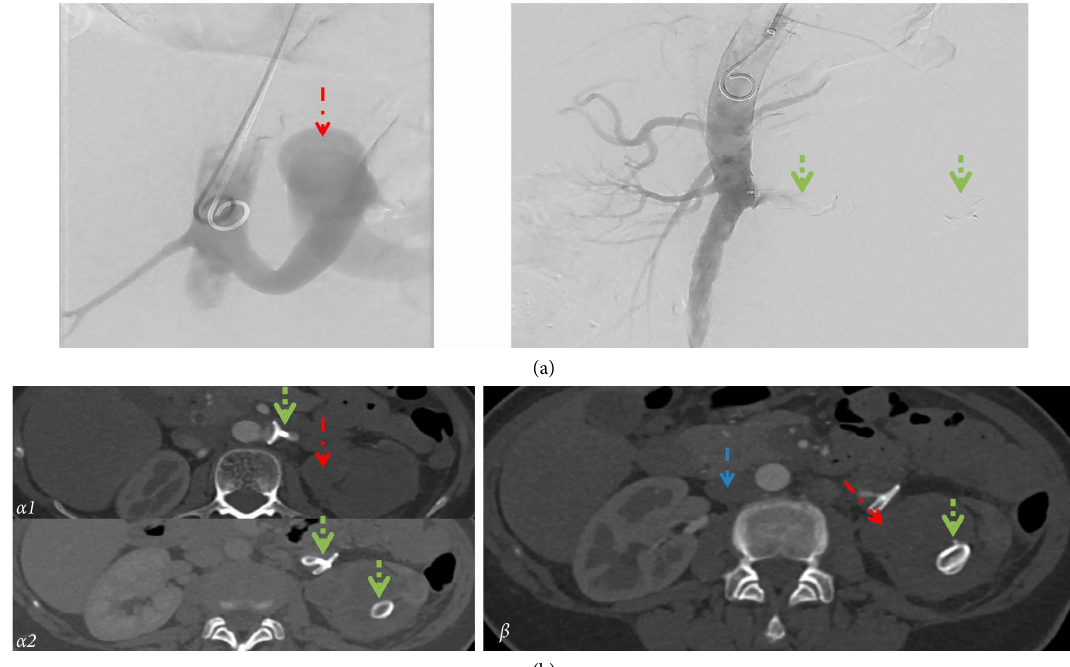
Figure 3: Representative images of an angiography during surgery and a CT scan one-month post-surgery. (a) Angiography before and after Amplatzer Vascular Plug (AVP) II Device placement. No perfusion of the left renal artery (LRA) after AVP II placement. Red arrow (dashed and dotted) = RVA; Green arrow (dotted) = correct positioned central and displaced peripheral AVP II. (b) 𝛼 : arterial phase images. 𝛼 1: no perfusion of the LRA distal of the central AVP II. 𝛼 2: minimal residual cortical perfusion over a side-branch originating from the LRA proximal of the central AVP II. 𝛽 : venous phase image: no contrast in the left vs. right kidney indicating subtotal infarction, despite insignificant residual cortical perfusion. No residual perfusion of the RVA (red arrows, dashed, and dotted) and marked reduction of the IVC diameter (blue arrow,